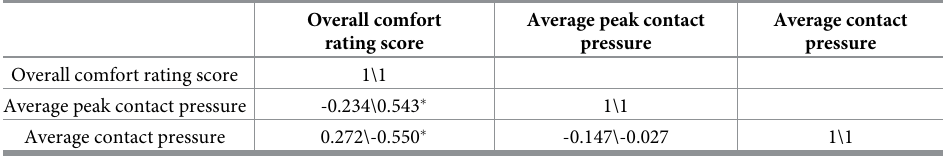
Table 8. Pearson correlation coefficients of the subjective ratings and pressure